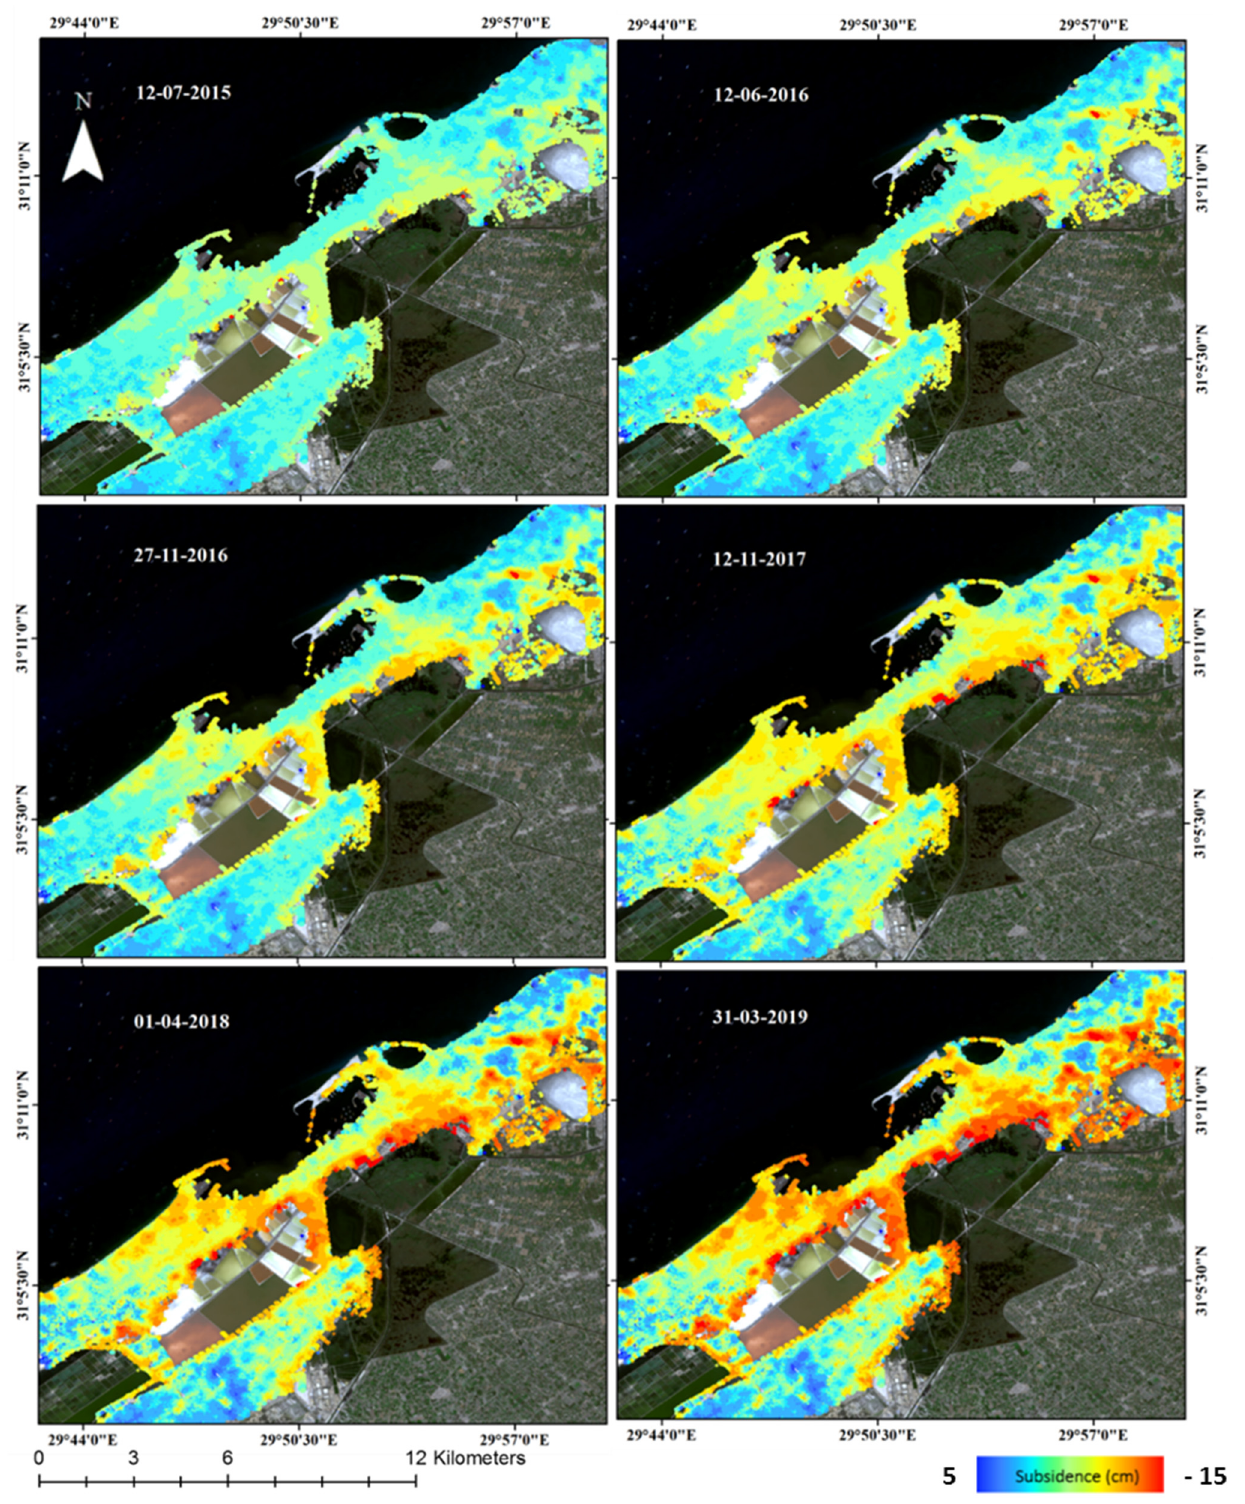
Figure 12. Vertical displacement of Alexandria City using coherence threshold value of 0.2 during the period from 2015 to 2019 using ALOS/PALSAR-2 images.